Question: What kind of plot is shown here?
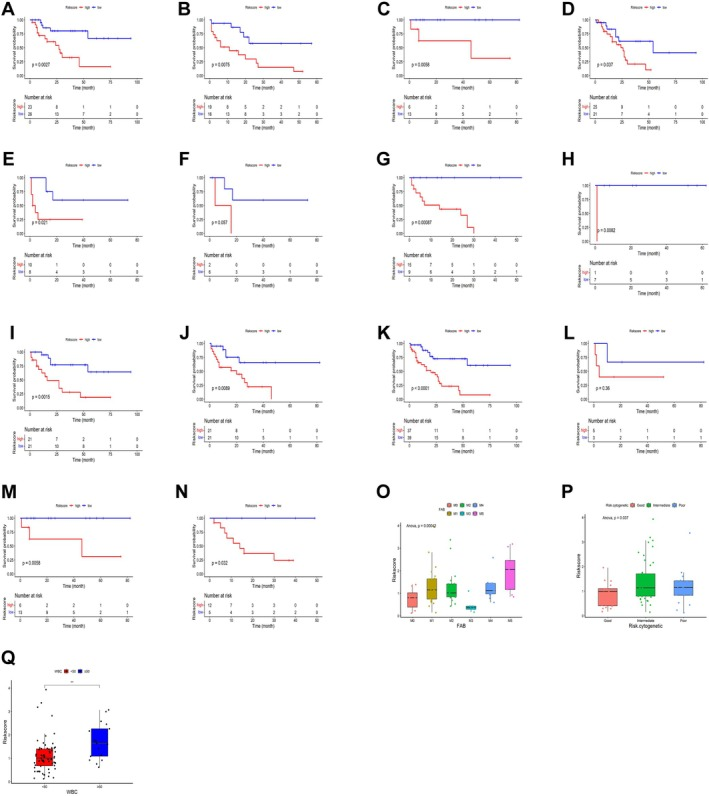
Answer: survival